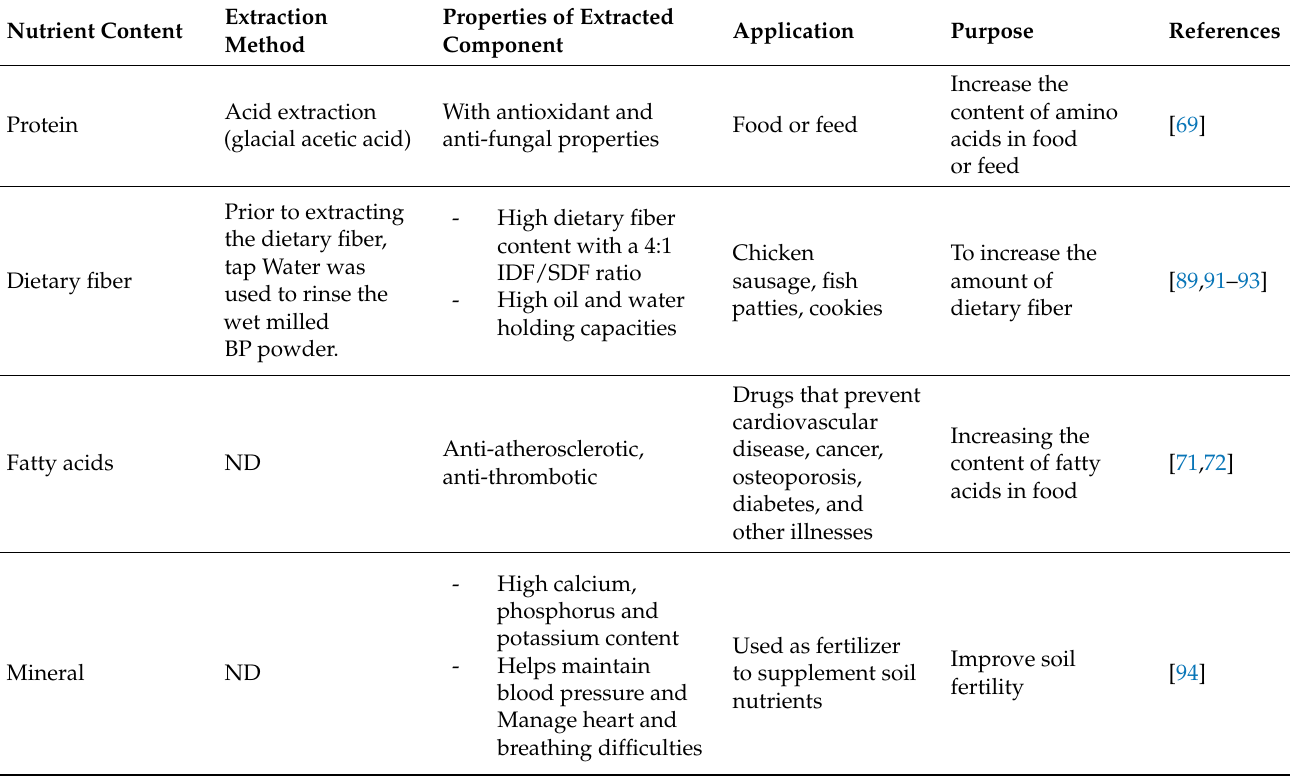
Table 3. Benefits of banana peel and their